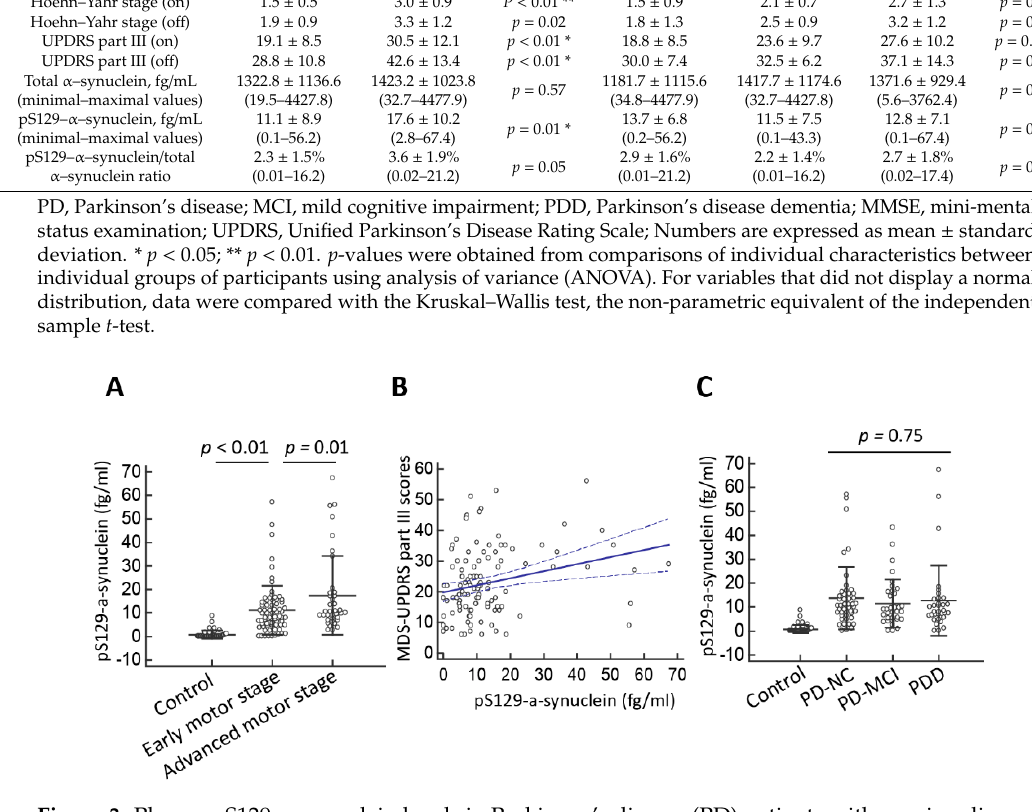
Figure 3. Plasma pS129- α -synuclein levels in Parkinson’s disease (PD) patients with varying disease severity. ( A ) The plasma pS129- α -synuclein level was markedly increased in PD patients with more severe motor disability as assessed by Hoehn–Yahr stage ( p < 0.01) and ( B ) correlated with motor symptom severity as measured by MDS-UPDRS part III scores ( r = 0.27 (95% CI: 0.09–0.43), p = 0.004). ( C ) The plasma pS129- α -synuclein levels did not differ between patients with varying severity of cognitive dysfunction ( p = 0.75). Numbers are expressed as mean ± standard deviation. PD-NC, PD with normal cognition; PD-MCI, PD with mild cognitive impairment; PDD, PD with